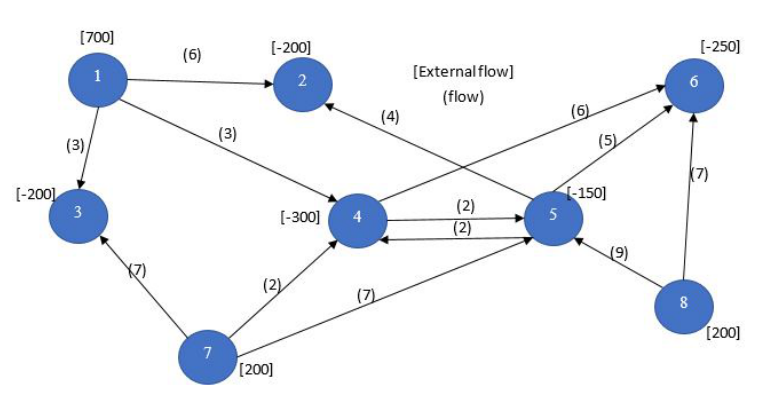
Figure 2. Example of a network flow programming model.